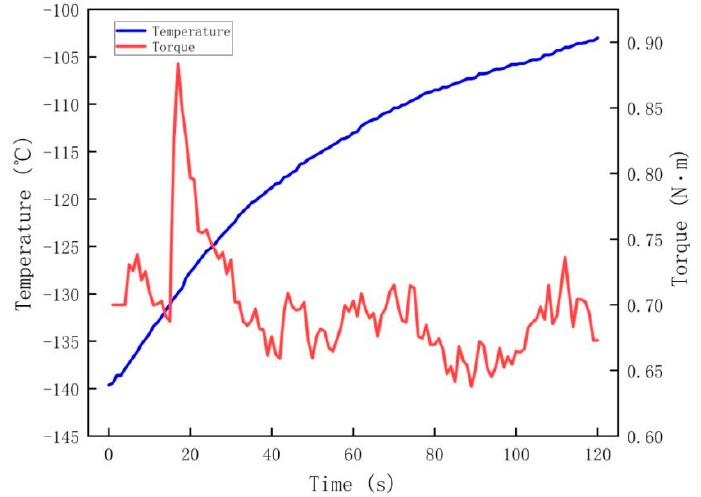
Figure 6. Torque and temperature curves of No. A1.